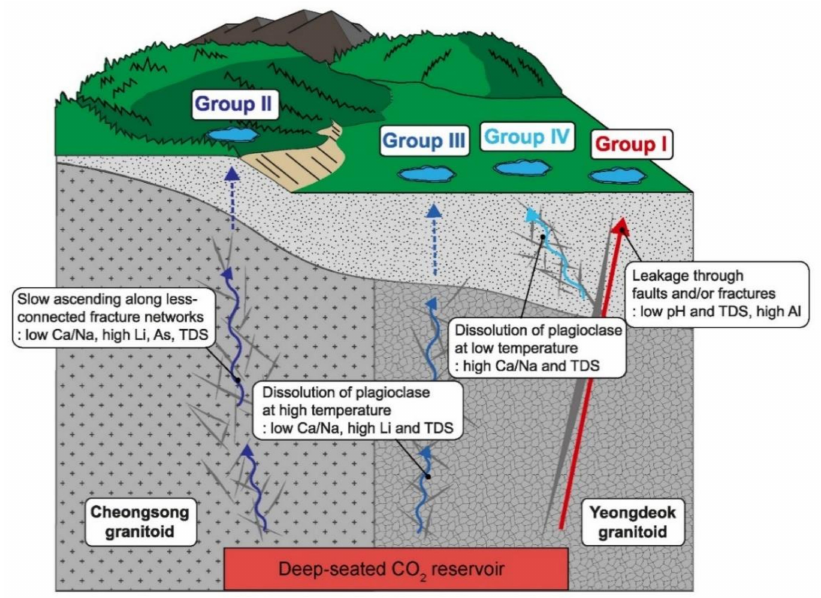
Figure 7. Evolutionary processes suggested for each